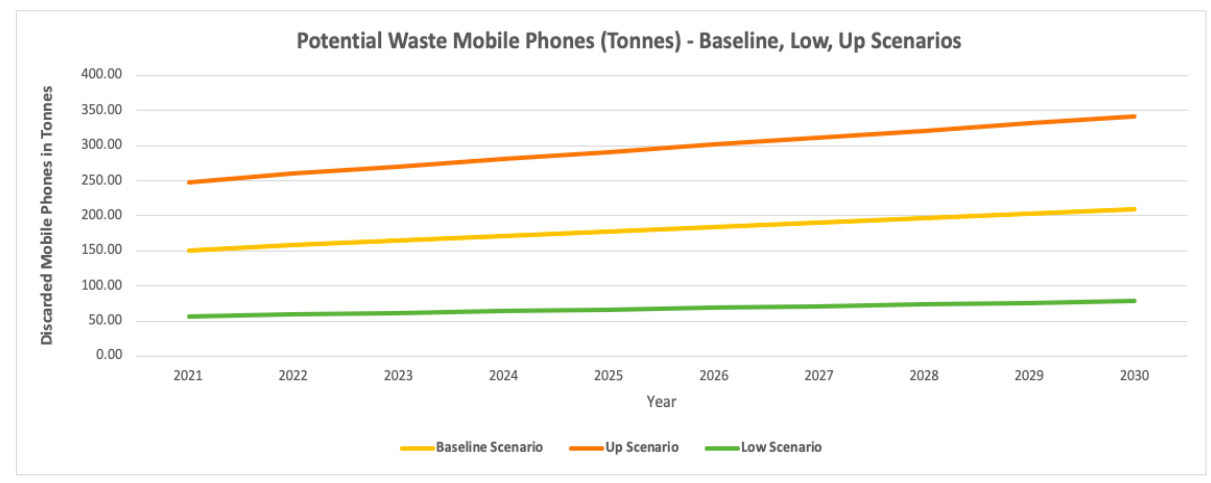
Figure 18. Waste mobile phones — baseline, up, and low scenarios (tonnes).